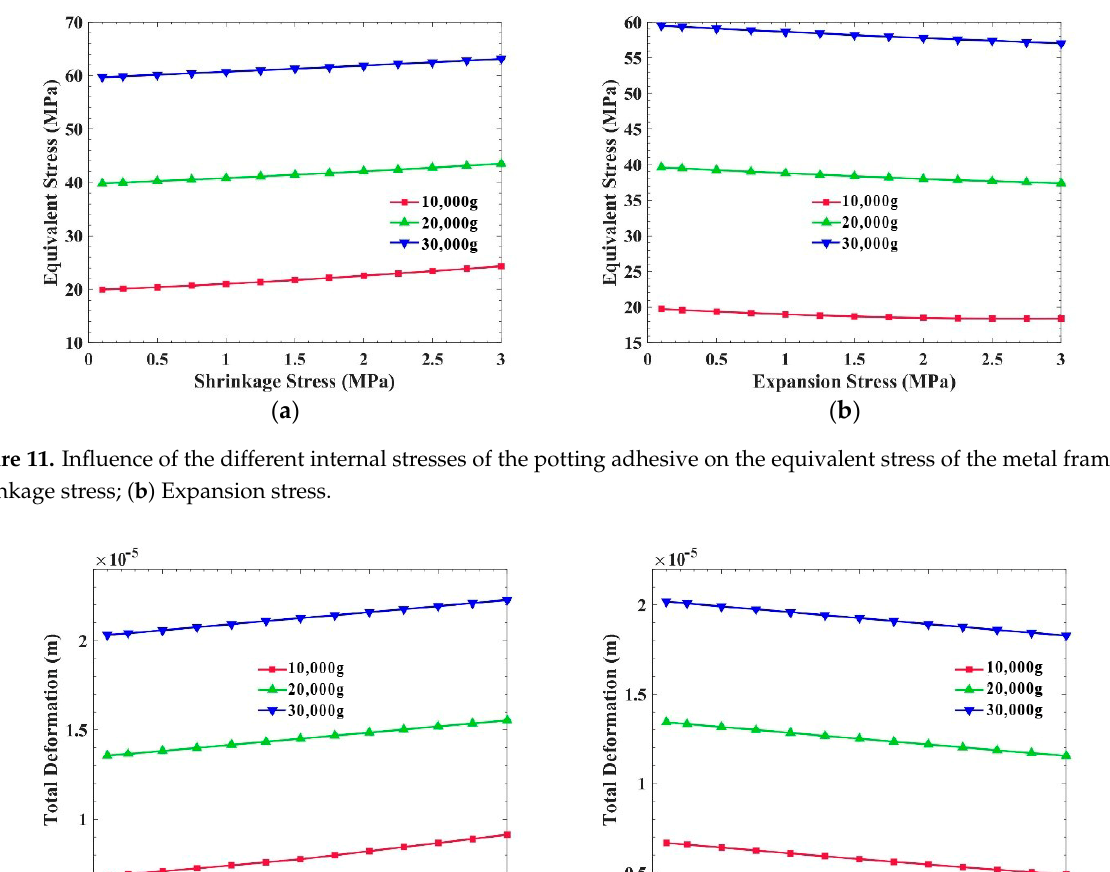
Figure 10. Influence of the different internal stresses of the potting adhesive on the total deformation of the PCB which is parallel to the overload direction: ( a ) Shrinkage stress; ( b ) Expansion stress.